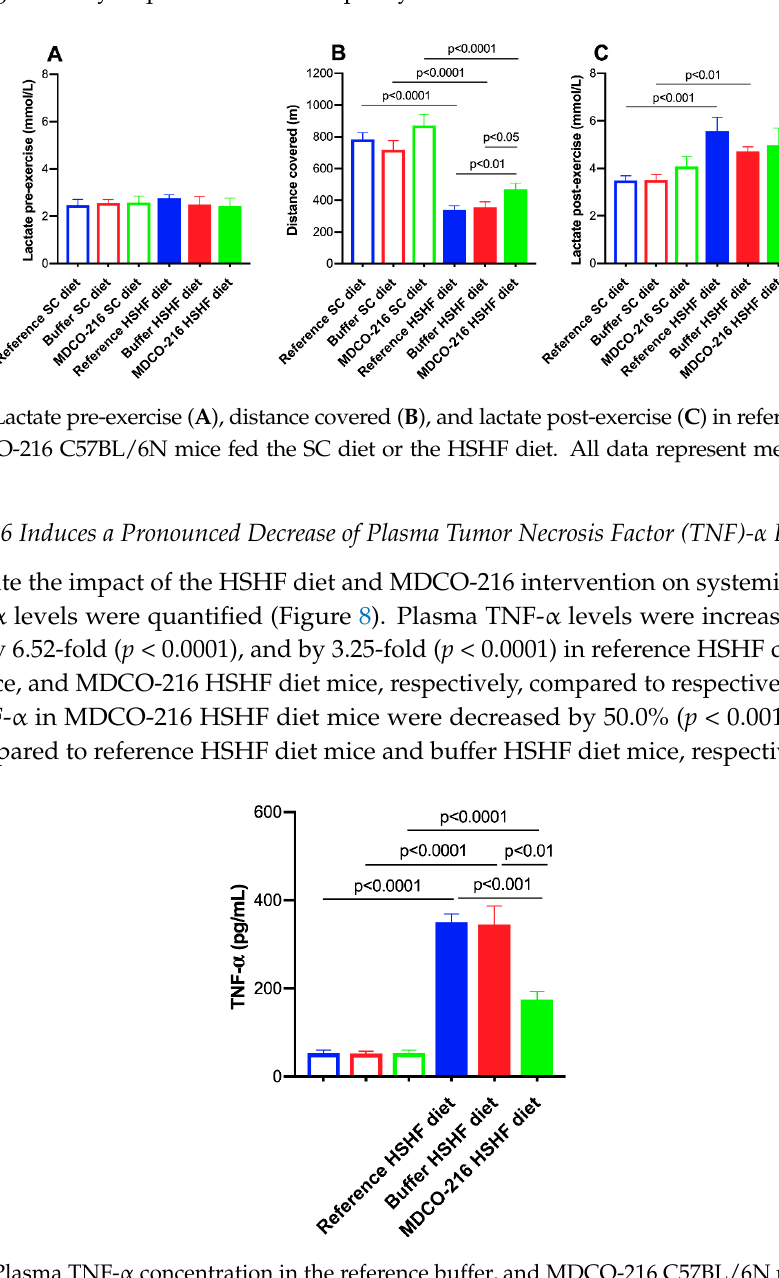
Figure 8. Plasma TNF- α concentration in the reference buffer, and MDCO-216 C57BL/6N mice fed the SC diet or the HSHF diet. All data represent means ± SEM ( n = 10).